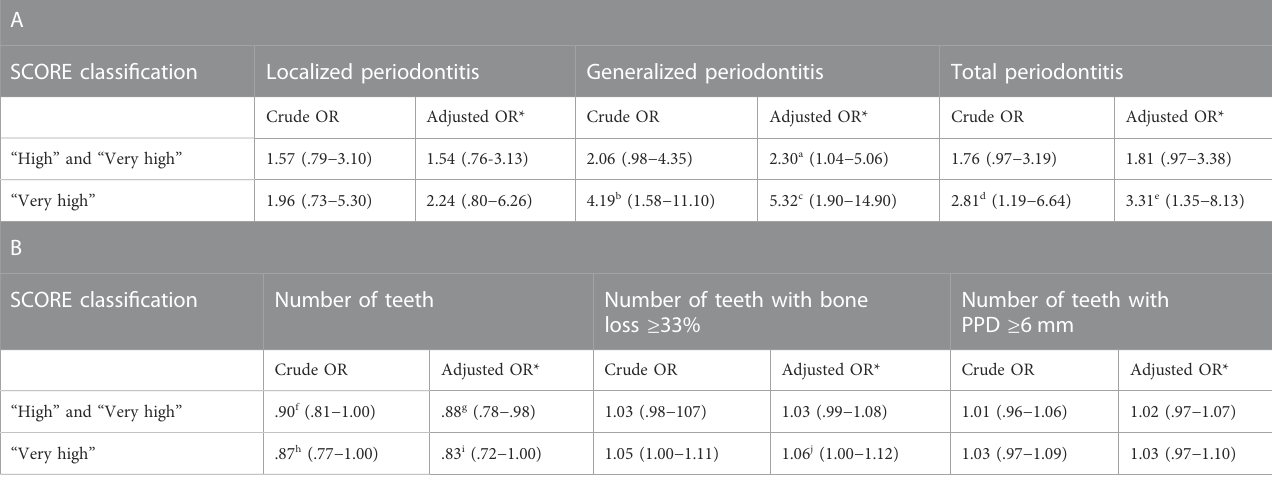
TABLE 7 Associations between the extent of periodontitis (Part A), clinical periodontal parameters (Part B) and SCORE.